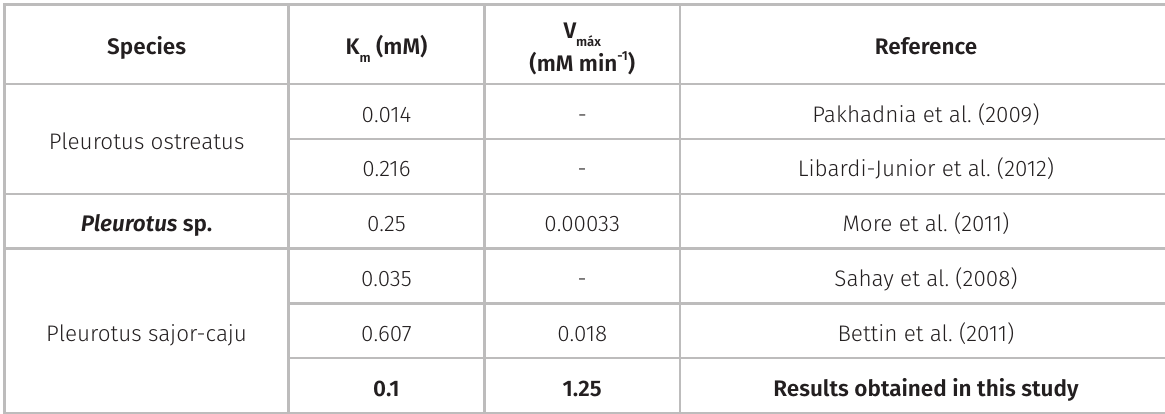
Table IV. Kinetic parameters for laccase enzymes from different Pleurotus species.